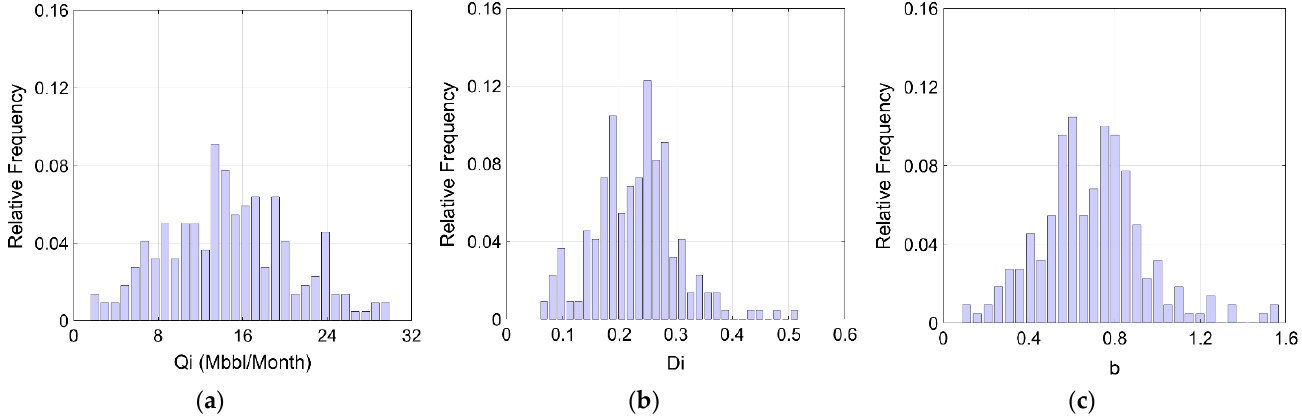
Figure 6. Relative frequency of the DCA parameters after preprocessing: ( a ) the initial production rate; ( b ) the initial decline rate; and ( c ) the decline exponent.